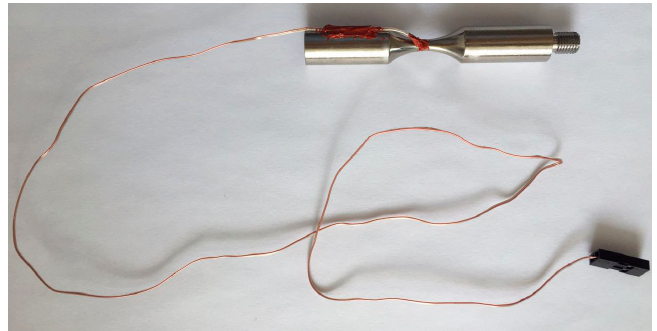
Figure 4. Picture of the thermocouple adhered to the surface of the small section of a HU specimen.